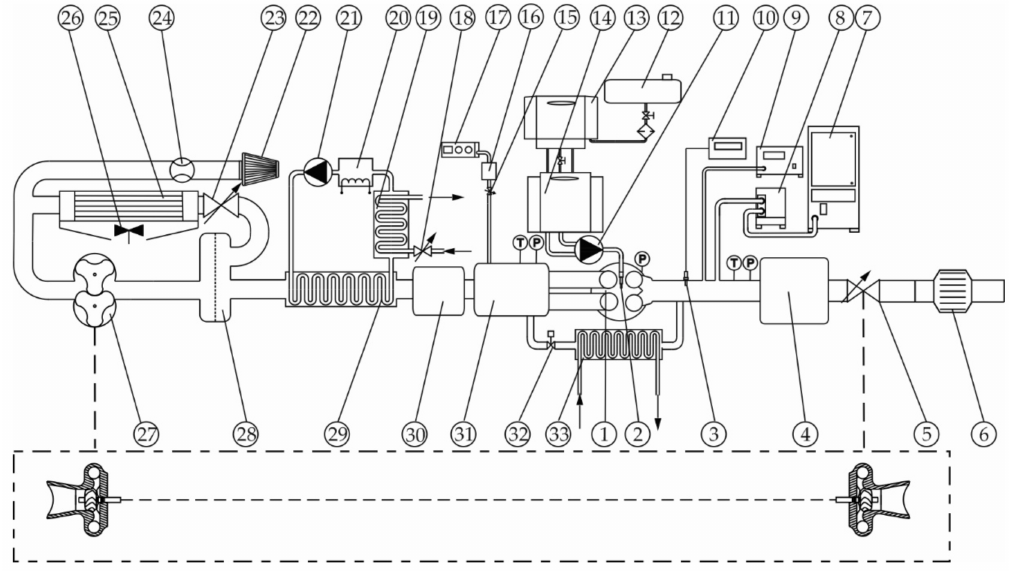
Figure 3. Schematic diagram of the engine test stand: ( 1 ) engine; ( 2 ) fuel injector; ( 3 ) UEGO